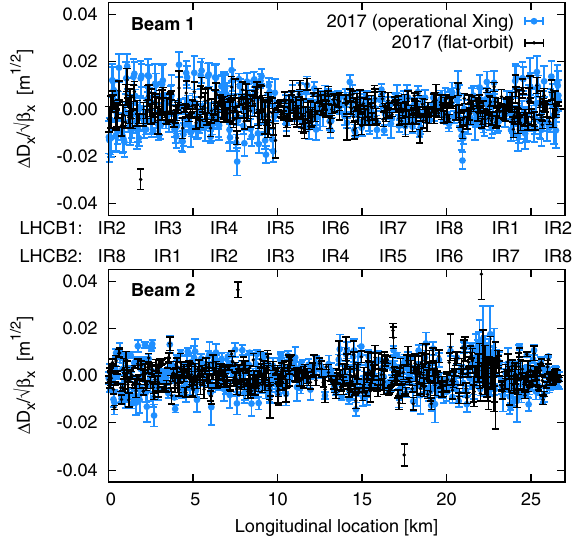
FIG. 30. Normalized dispersion at flat orbit for Beam 1 (top) and Beam 2 (bottom), measured for flat orbit and for the operational configuration at β (cid:1) ¼ 0 . 4 m in